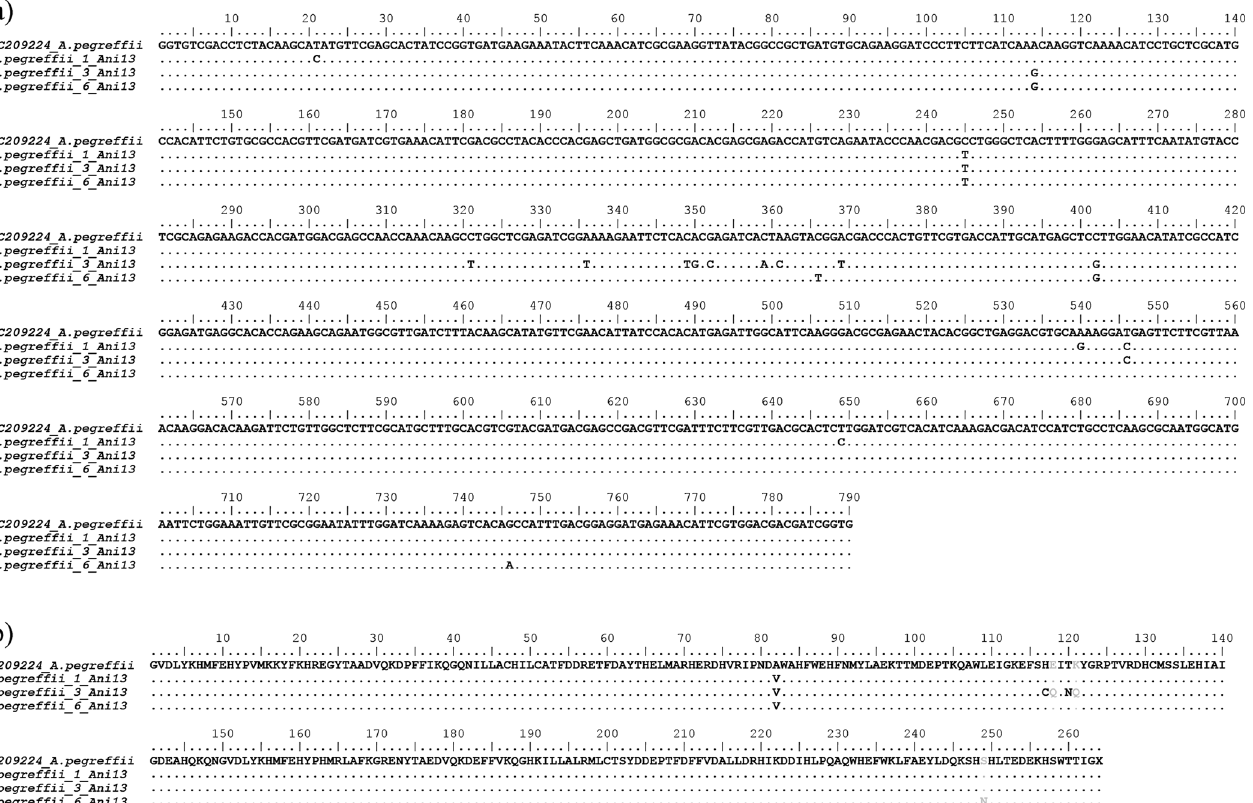
Figure 3. Nucleotide and amino acid sequence alignment of A.peg-13 cDNA. (a) Nucleotide sequence alignment obtained from A. pegref fi i larvae from the present study in comparison with those previously deposited in GenBank for A. simplex (s. l.) (Accession No.: LC209224). Dots indicate identity with the consensus sequence. (b) Amino acid sequence alignment of the deduced amino acid sequences of the A.peg-13 allergen showing the variable sites between A. pegref fi i , and previously reported A. simplex (s. l.). Dots represent residues identical to the reference Ani s 13